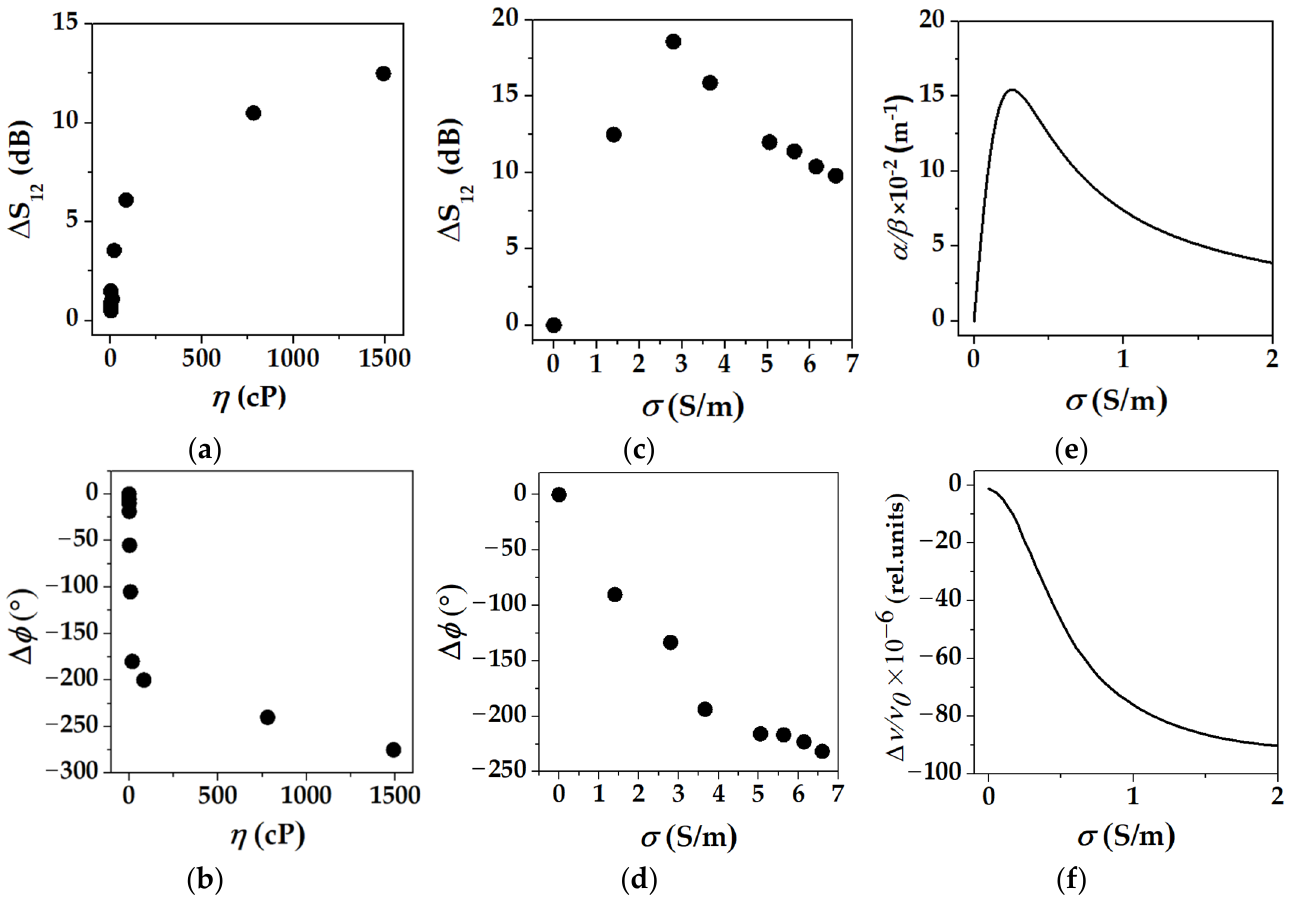
Figure 10. Calibration curves for one of the best modes towards liquid viscosity ( a , b ) and liquid conductivity ( c , d ) measured at 20 °C. Points are experimental data, solid lines ( e , f ) are numerical results calculated with formulas (2) and (3). Mode: f = 40.24 MHz, λ = 200 μm, v = 8.176 m/s, k 2 = 110 × 10 −4 , surface displacements { u 1 , u 2 , u 3 ,} = {1, 0.1, 0.5}. Plate: Y-LiNbO 3 , h /λ = 1.75, ε pl = 34ε 0 . Propagation direction Θ = 60°. Liquids: water solutions of glycerin and NaCl , ε lq /ε 0 = 79.3. Coated path L = 18 mm.